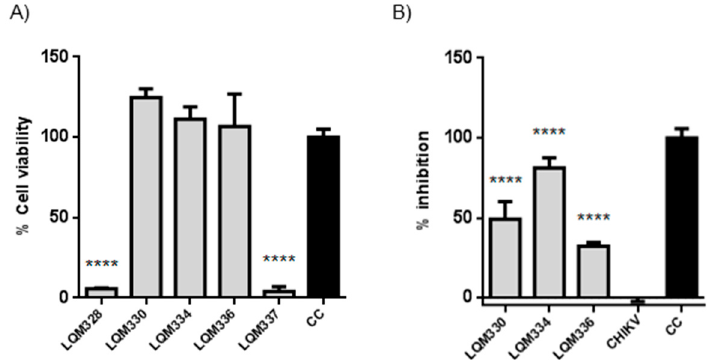
Figure 6. In vitro cytotoxicity and anti-Chikungunya virus results of acrylamides at 40 µ M. ( A ) Evaluation of cytotoxicity for acrylamides in vitro towards Vero E6 cells at 40 µ M. The cytotoxicity was performed in vitro by MTT assay after 72h. **** p ≤ 0.0001 versus CC. ( B ) Assessment of anti-CHIKV activity of acrylamides at 40 µ M. The virus adsorption was performed for 2 h followed by the addition of tested compounds. The cell viability was assessed after 72 h and the viral inhibition (%) was determined for each compound. **** p ≤ 0.0001 versus CHIKV. The expressed values result from the mean ± SD of triplicates. CHIKV = CHIKV-infected untreated cells. CC = uninfected cellular